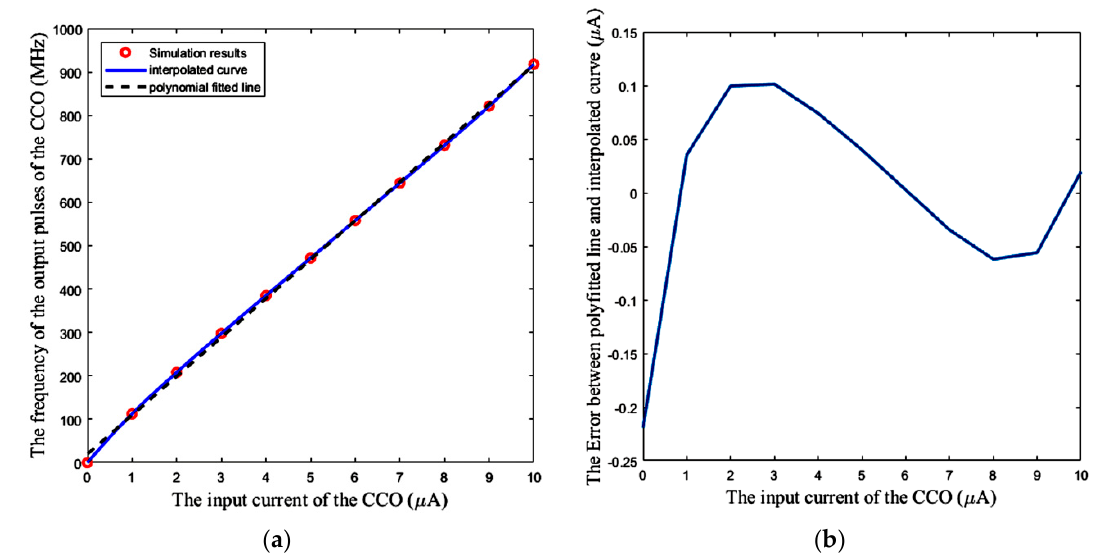
Figure 15. ( a ) CCO output frequency vs DC input current, ( b ) Error between the polynomial fitted line and the simulation results.